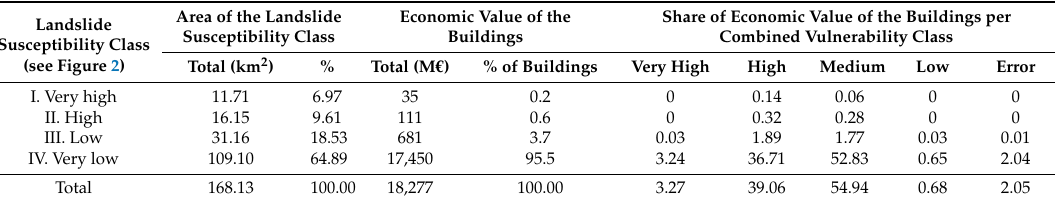
Table 7. Landslide risk analysis for the buildings, considering the combined vulnerability for 3-metre-deep landslides (see Figure